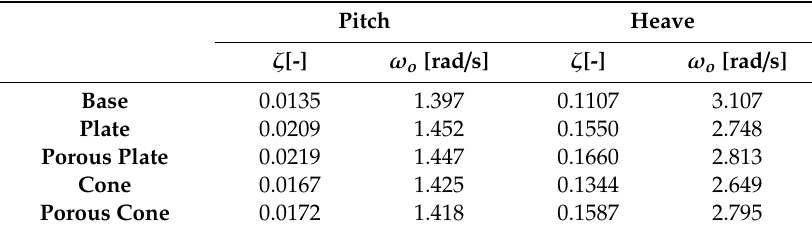
Table 2. Non-dimensional damping coe ffi cients and natural frequencies of lightweight light buoys Table 2. Non ‐ dimensional damping coefficients and natural frequencies of lightweight light buoys from free decay from free decay tests.